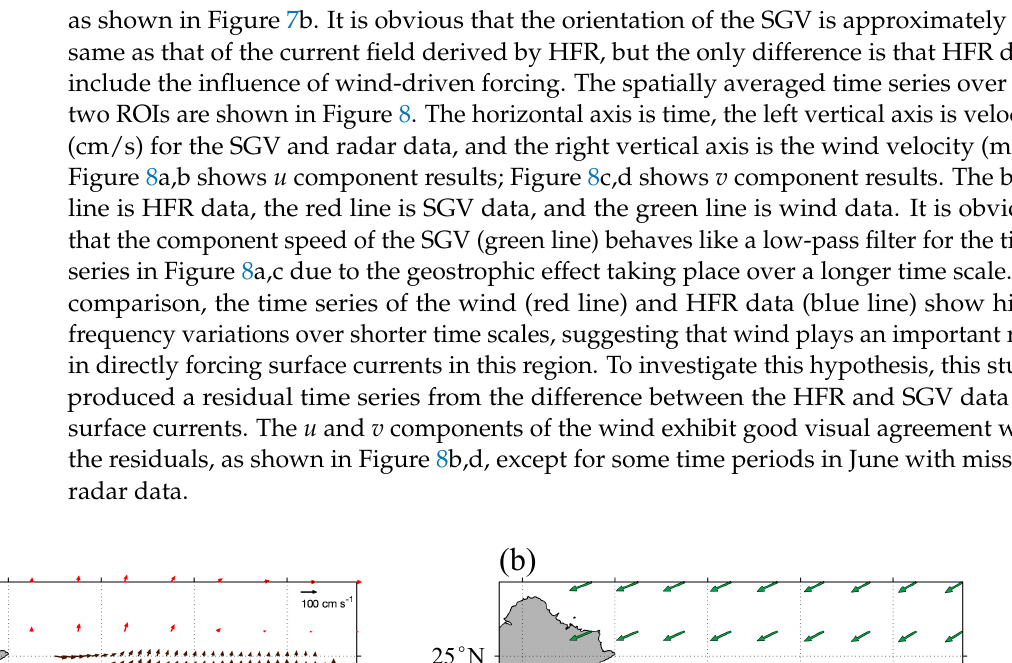
10 of 19 to north; the black vector is the HFR measurement value of the sea-surface current. The orange cells are designated region of interest (ROI) 1, and the blue cells are designated ROI 2. The Kuroshio current velocity and wind speed are both relatively strong in these two areas, which is why they were selected. The wind field is approximately northeasterly throughout, as shown in panel (b) of Figure 7. It is obvious that the orientation of the SGV is approximately the same as that of the current field derived by HFR, but the only differ- ence is that HFR data include the influence of wind-driven forcing. The spatially averaged time series over the two ROIs are shown in Figure 8. The horizontal axis is time, the left vertical axis is velocity (cm/s) for the SGV and radar data, and the right vertical axis is the wind velocity (m/s). Figure 8a,b shows u component results; Figure 8c,d shows v compo-